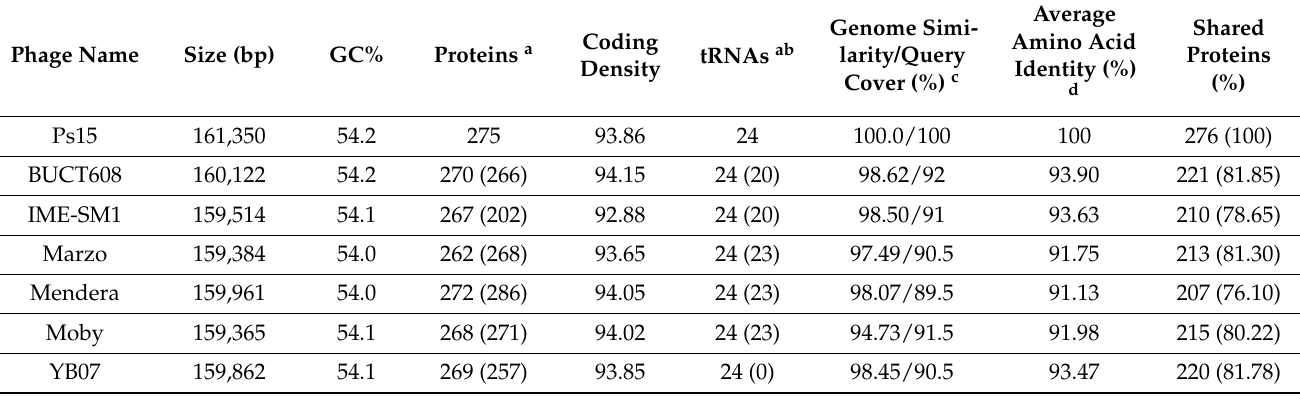
Table 3. General characteristics of Ps15 and other known Menderavirus genomes. Values based on the annotations performed in this study unless otherwise